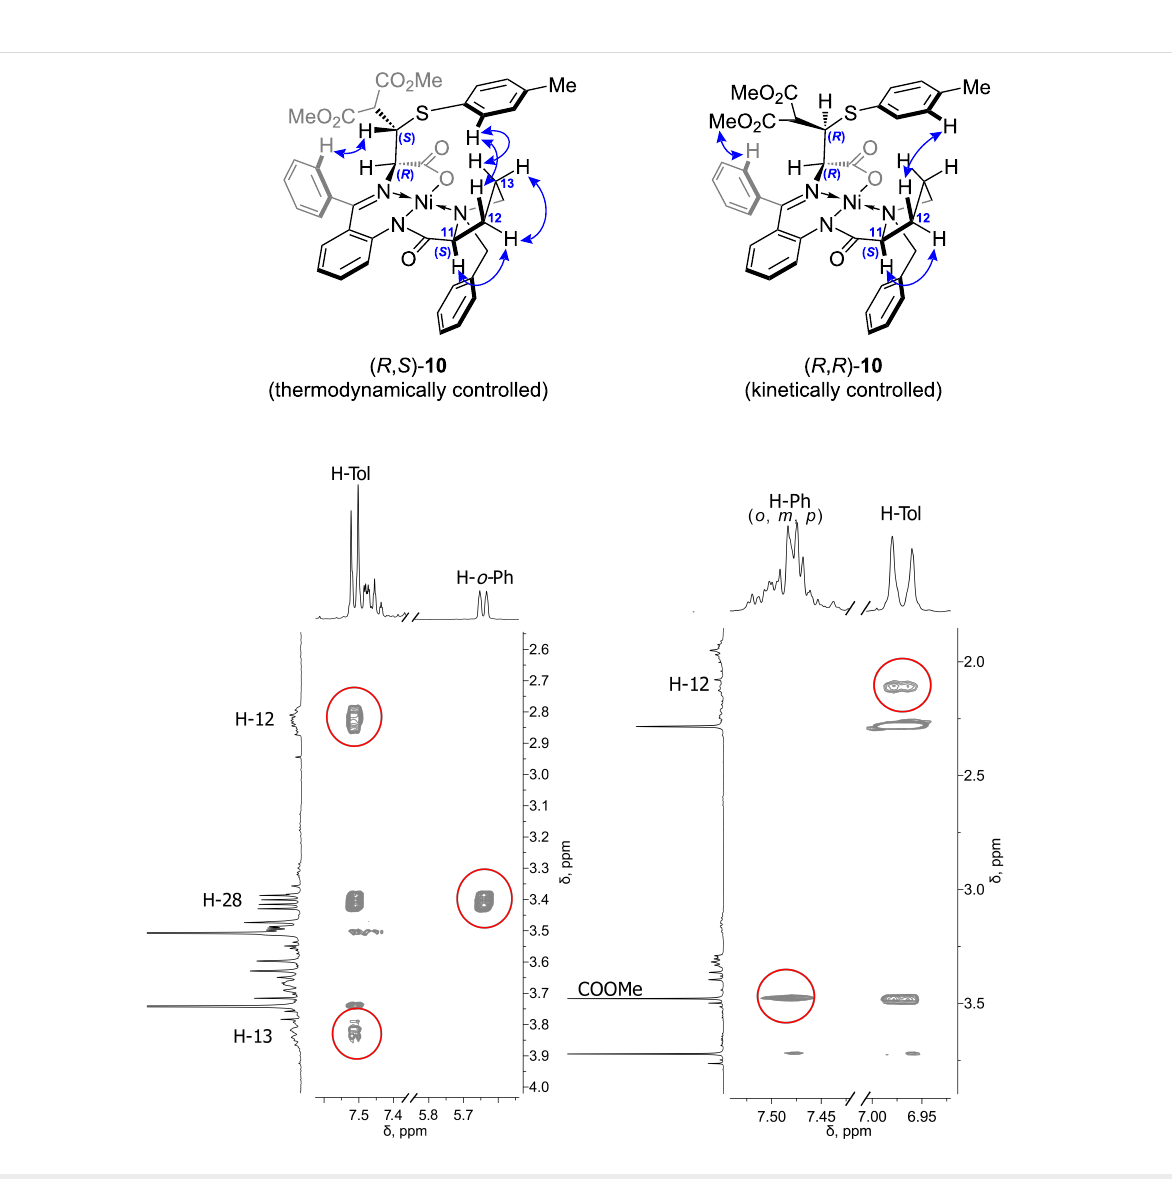
Figure 4: Characteristic correlations in the NOESY spectra of diastereomeric complexes 10 and the corresponding characteristic fragments of the spectra (full spectra are given in Supporting Information File 1); ( R , S )-isomer (left) and ( R , R )-isomer